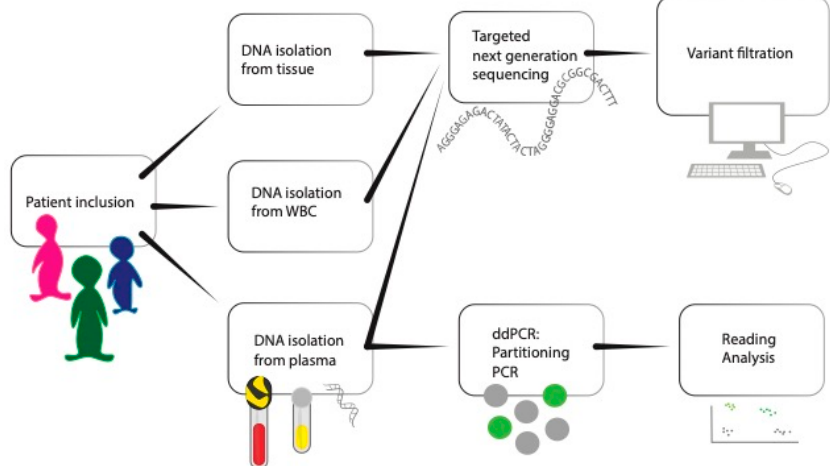
Figure 1. Study workflow. The schematic study plan of the project from patient inclusion to analysis of DNA from the three different materials. WBC, white blood cell; ddPCR, digital droplet PCR, PCR polymerase chain reaction.